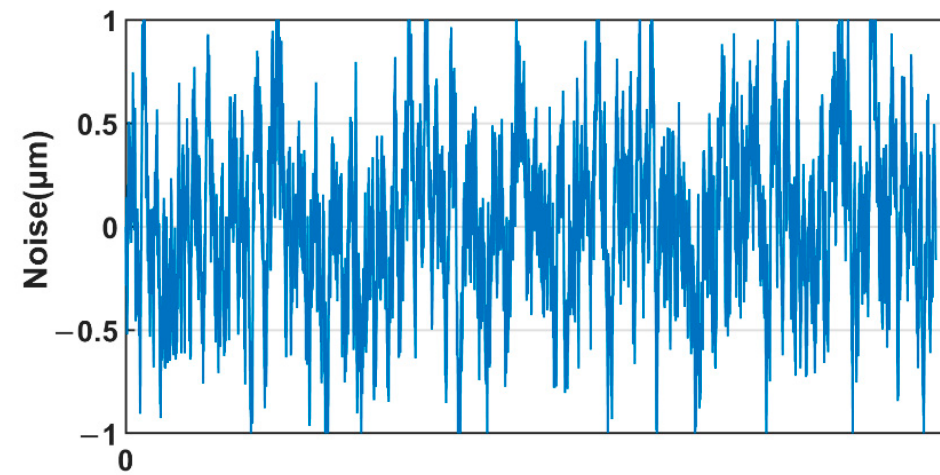
Figure 10. Position noise.